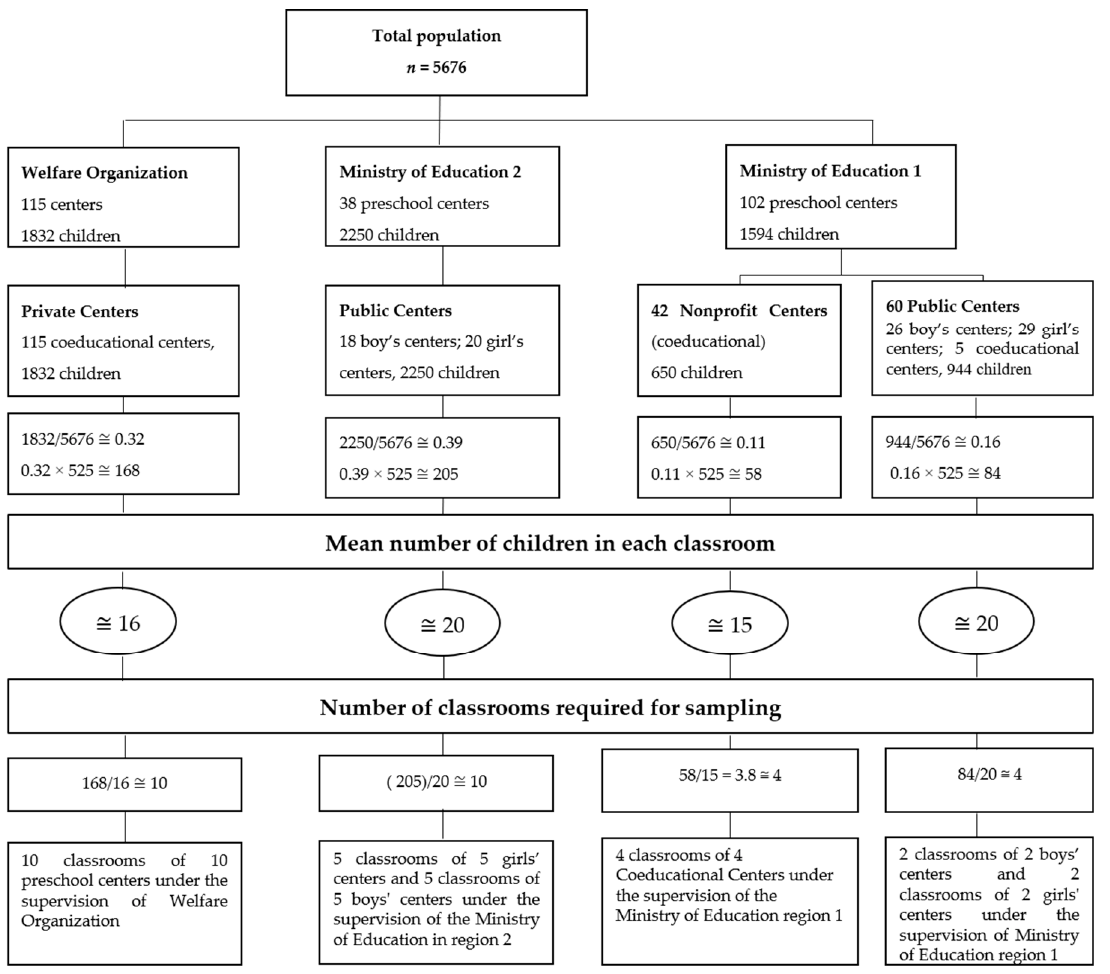
Figure 1. Process of sampling in this study.